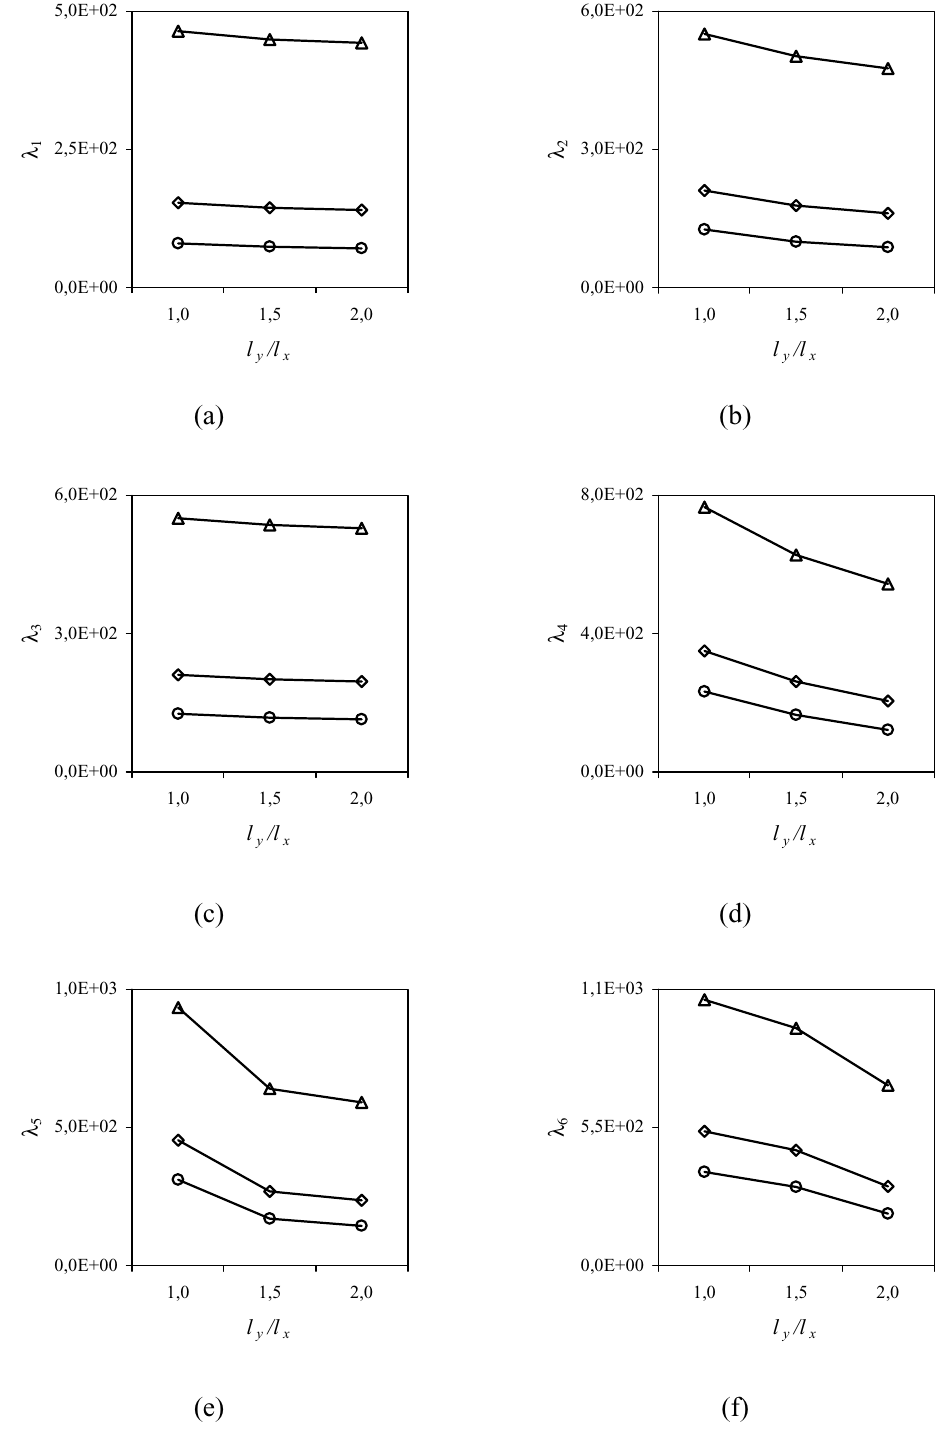
Fig. 6. The variation of the first six frequency parameters of the plate on elastic foundation with various values of l y /l x ratio and H for γ = 7. – ∆ –, H = 5 m; – ♦ –, H = 10 m; –o–, H = 15